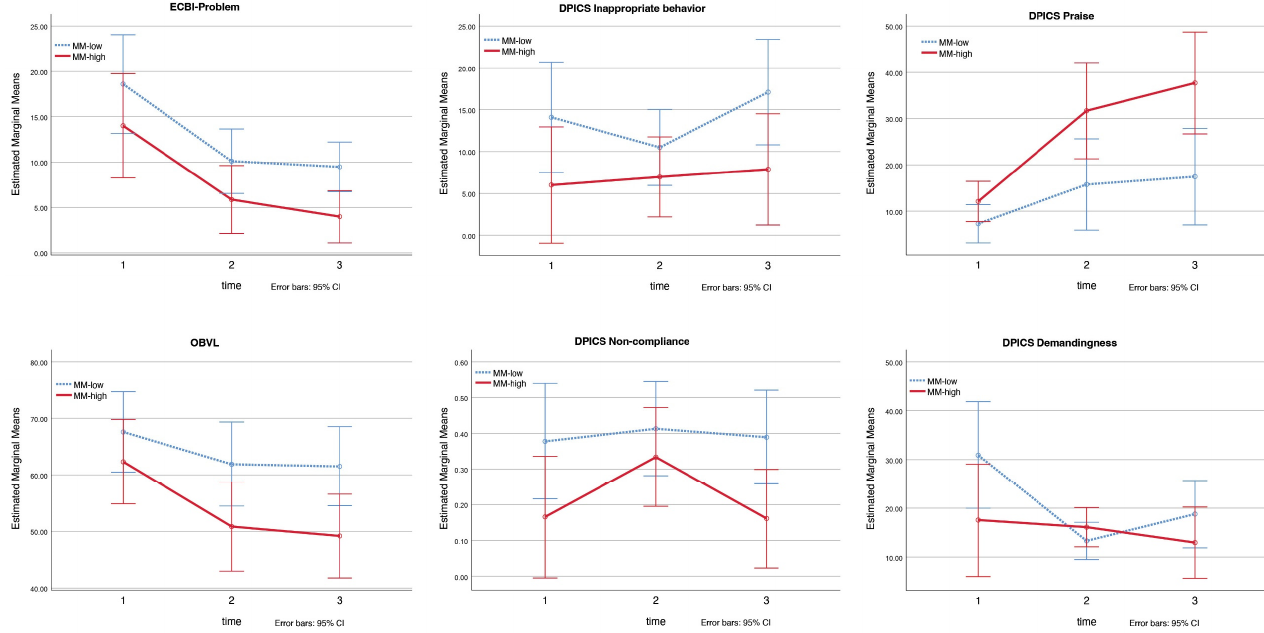
Figure 1. PCIT-Home: group effects for ECBI Problem, OBVL, DPICS inappropriate behavior, non- compliance, praise, and interaction effect for DPICS demandingness. Note. MM-low = mothers with a medium-low level of mind-mindedness; MM-high = mothers with a medium-high level of